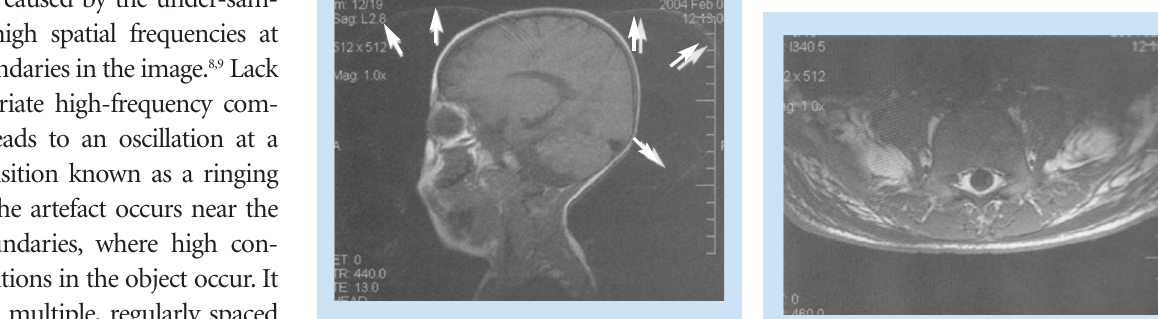
Fig. 9. B0 inhomogeneity: intensity distortion across a T1 axial study of the lumbar